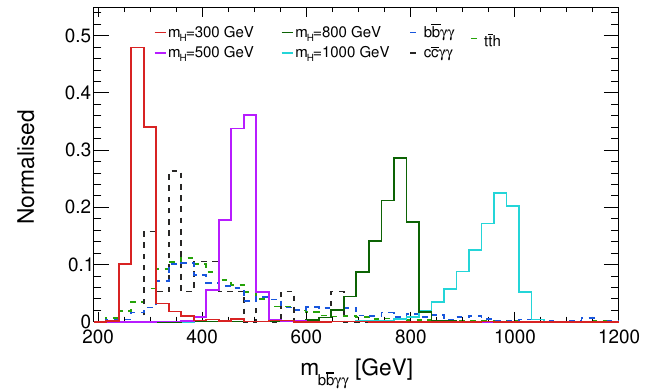
for heavy Higgs masses of m H = 300, 500, 800 and b (cid:22) b(cid:13)(cid:13)